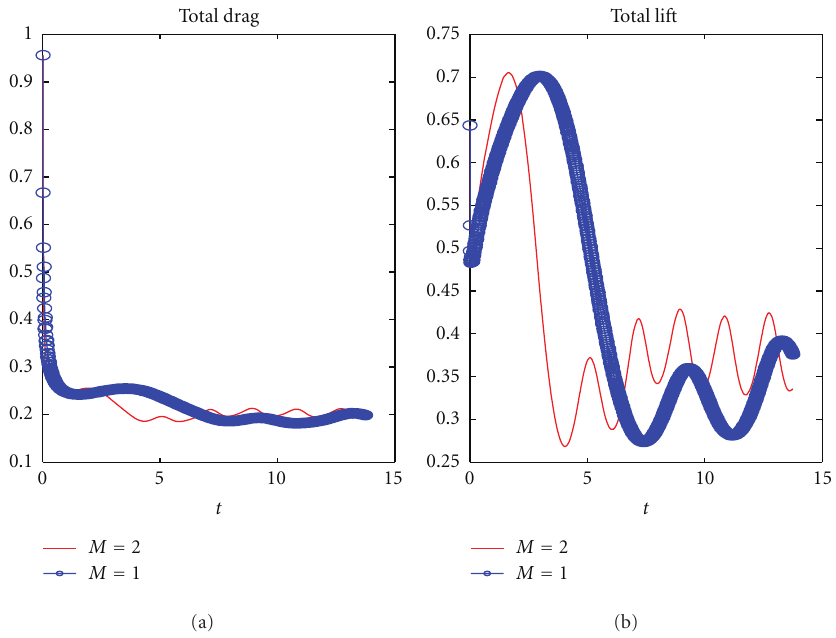
Figure 13: Drag and lift coe ffi cients for Re = 400 when using M = 1 and M =